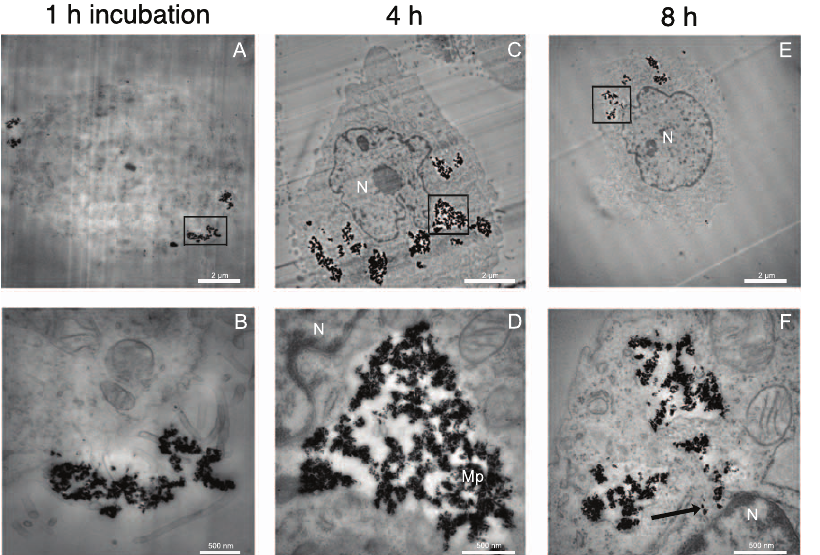
Figure 4. TEM imaging of the distribution of ND-PEI in NIH/3T3 EWS-Fli1 cells as a function of time N: cell nucleus, Mp: macropinosome compartment. The cell were incubated with ND-PEI for 1 h (A)&(B), 4 h (C)&(D) and 8 h (E)&(F). (A) ND-PEI were rapidly taken up by cells: at 1 h, some NDs had already crossed the cell membrane. (B), (D) and (F) are magnifications corresponding to the regions surrounded by rectangle or square in (A), (C) and (E) respectively. (B) Pseudopod formation at the cell membrane during ND-PEI uptake. At 4 h (C) and 8 h (E), all the ND-PEI are located in large perinuclear vacuoles within the cell. Most of these structures correspond to macropinosomes, which are still delimited by a membrane at 4 h (D), but are disrupted after 8 h of treatment, as confirmed by the presence of free diamond nanocrystals in the cytoplasm (arrow)(F). Scale bars in (A), (C) and (E): 2 m m and in (B), (D) and (F): 500 nm. TEM magnification in (A), (C) and (E): 6 4,400; in (B): 6 20,000; in (D) and (F): 6